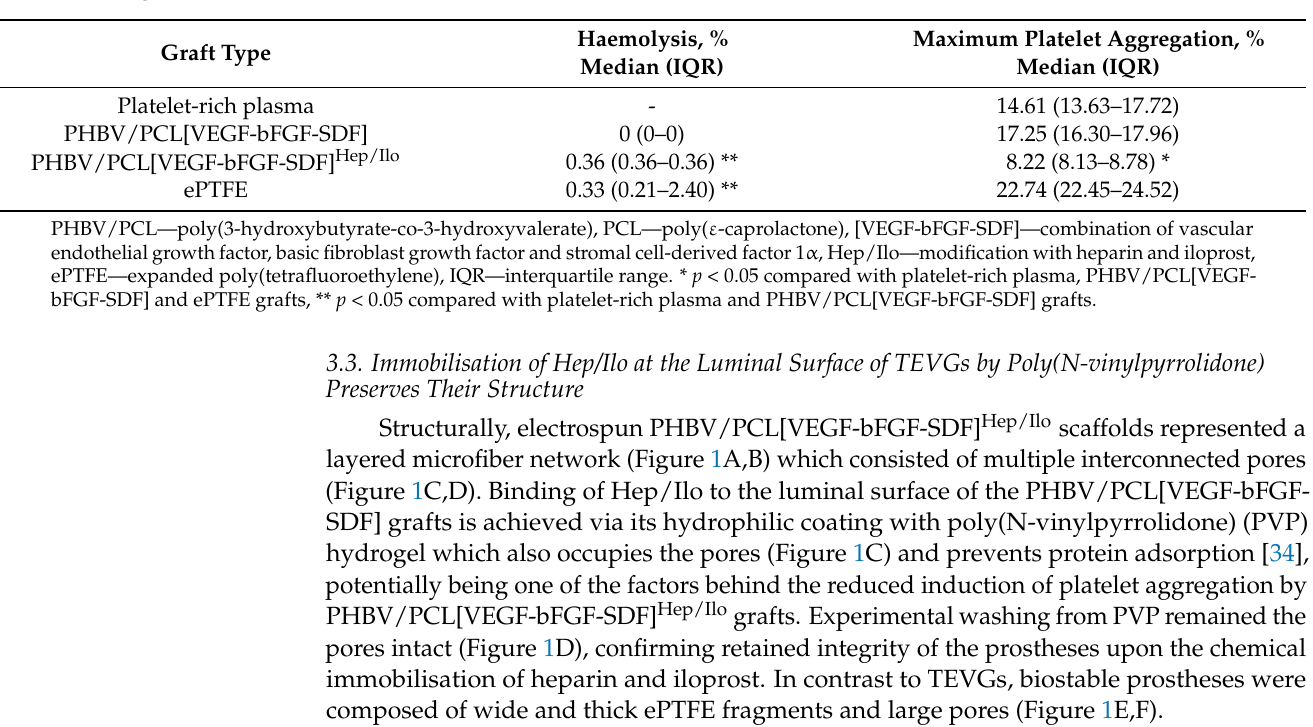
Table 3. Haemolysis and platelet aggregation measured upon the contact of the blood or platelet-rich plasma with vascular